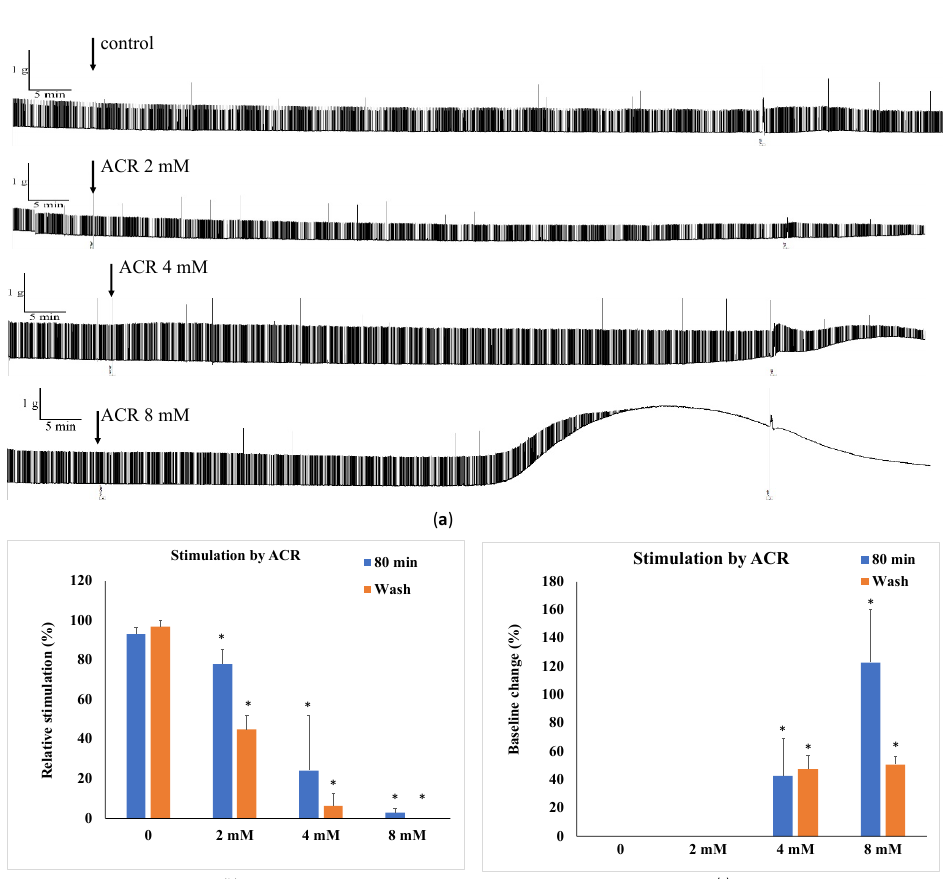
Figure 4. Effects of acrylamide (ACR) on isolated mouse phrenic nerve–diaphragm. ( a ) The organ baths were treated with 0, 2, 4, and 8 mM ACR for 80 min. After 80 min of ACR treatment, samples of mouse phrenic nerve–diaphragm were refreshed with physiological buffer solution. Effect of ACR on the isolated mouse phrenic nerve–diaphragm ( b ) neuromuscular blocking and ( c ) muscle contraction. Data are expressed as means ± standard deviations ( n = 5) (* p < 0.05 vs.